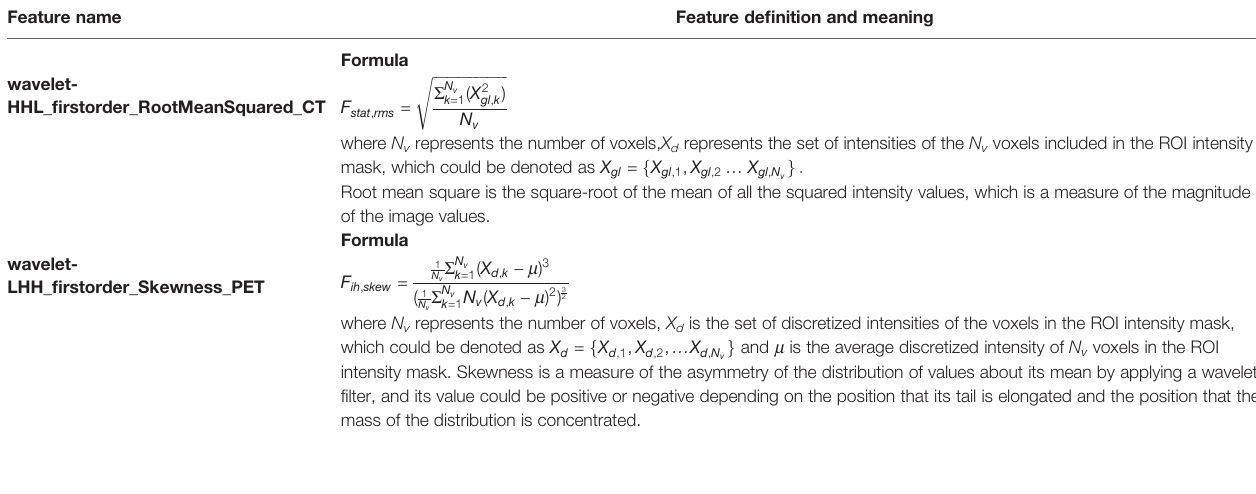
TABLE 3 | The de fi nitions for the features selected for the predictive model